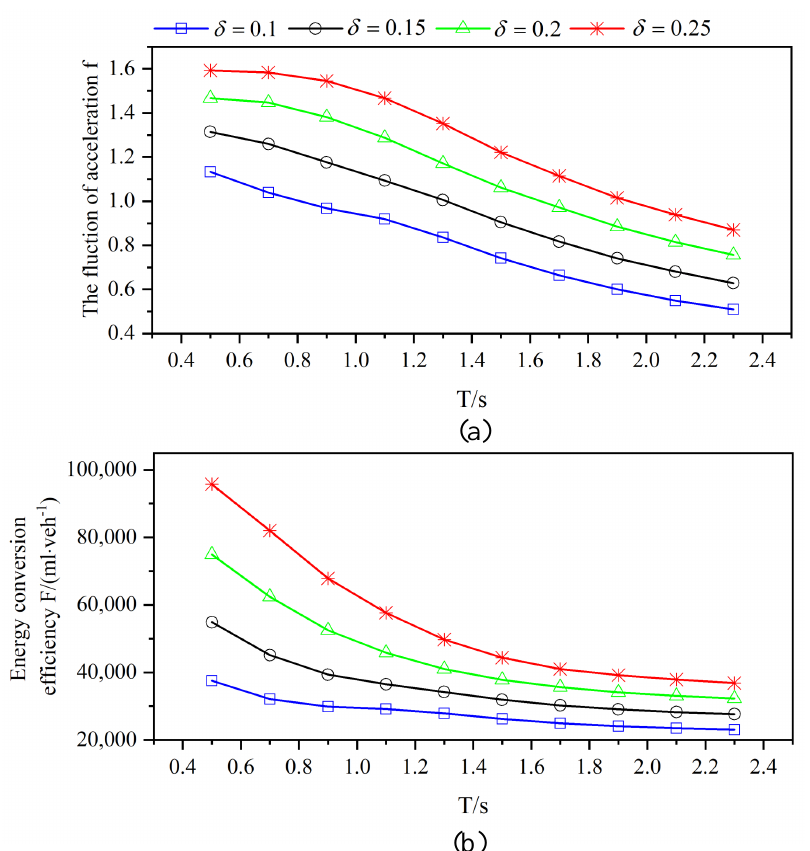
Figure 4. The fluctuation of vehicle acceleration ( a ) and the energy conversion efficiency ( b ) for varying T and perceptual error size δ in a completely CAV scenario with an independent on-board sensor perception scheme.